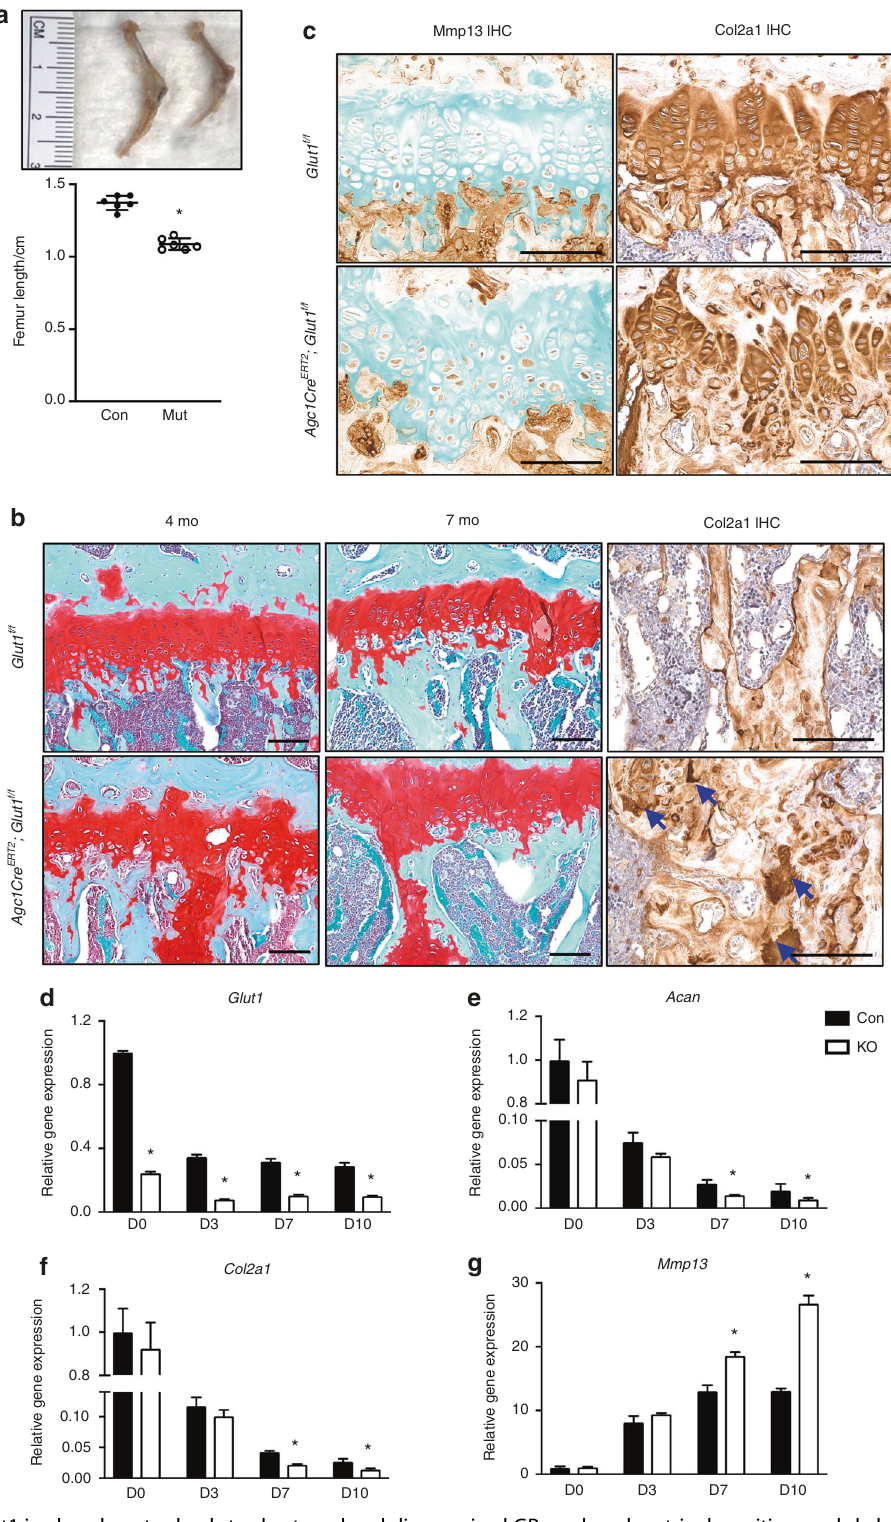
Fig. 3 Deletion of Glut1 in chondrocytes leads to shortened and disorganized GPs, reduced matrix deposition, and skeletal dysplasia. a Whole hind limbs and femur lengths of control and mutant Glut1 LOF mice at 4 months. The data are the mean ± SD. N = 6. * P < 0.05. b Safranin O/ Fast Green staining and immunostaining for Col2a1 in tibial sections of control and Glut1 LOF mice at 4 months and 7 months. The blue arrows denote the Col2a1-positive cartilage remnants in the metaphyses of Glut1 LOF mice. N = 6. Scale bar, 100 μ m. c Immunostaining for Mmp13 and Col2a1 in the growth plates of tibia sections of control and Glut1 LOF mice at 4 months. N = 6. Scale bar, 100 μ m . d RT-qPCR analyses of Glut1 , Col2a1 , Acan , and Mmp13 in control and Glut1 KO primary GP chondrocytes at the indicated time points over the course of hypertrophic differentiation. All mRNA abundances were normalized to the abundance of β -actin and then normalized to the abundances in the controls at day 0. N = 3. * P < 0.05 relative to the